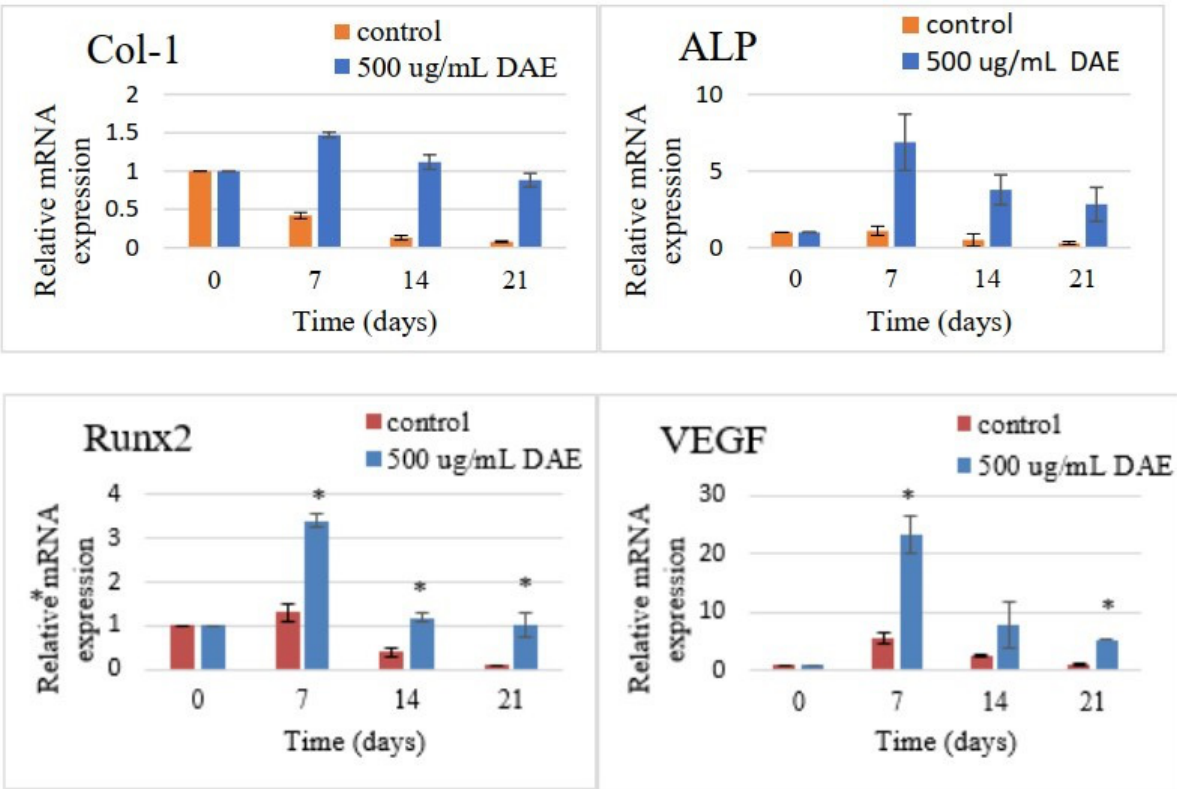
Figure 3. Quantitative RT-PCR analysis of the expression of the osteogenesis-related genes Col-1, ALP, Runx2, and VEGF after differentiation of PDLSCs induced with DAE. Values are expressed as mean ± SD (n = 3), * p < 0.05 for DAE group compared with control group.